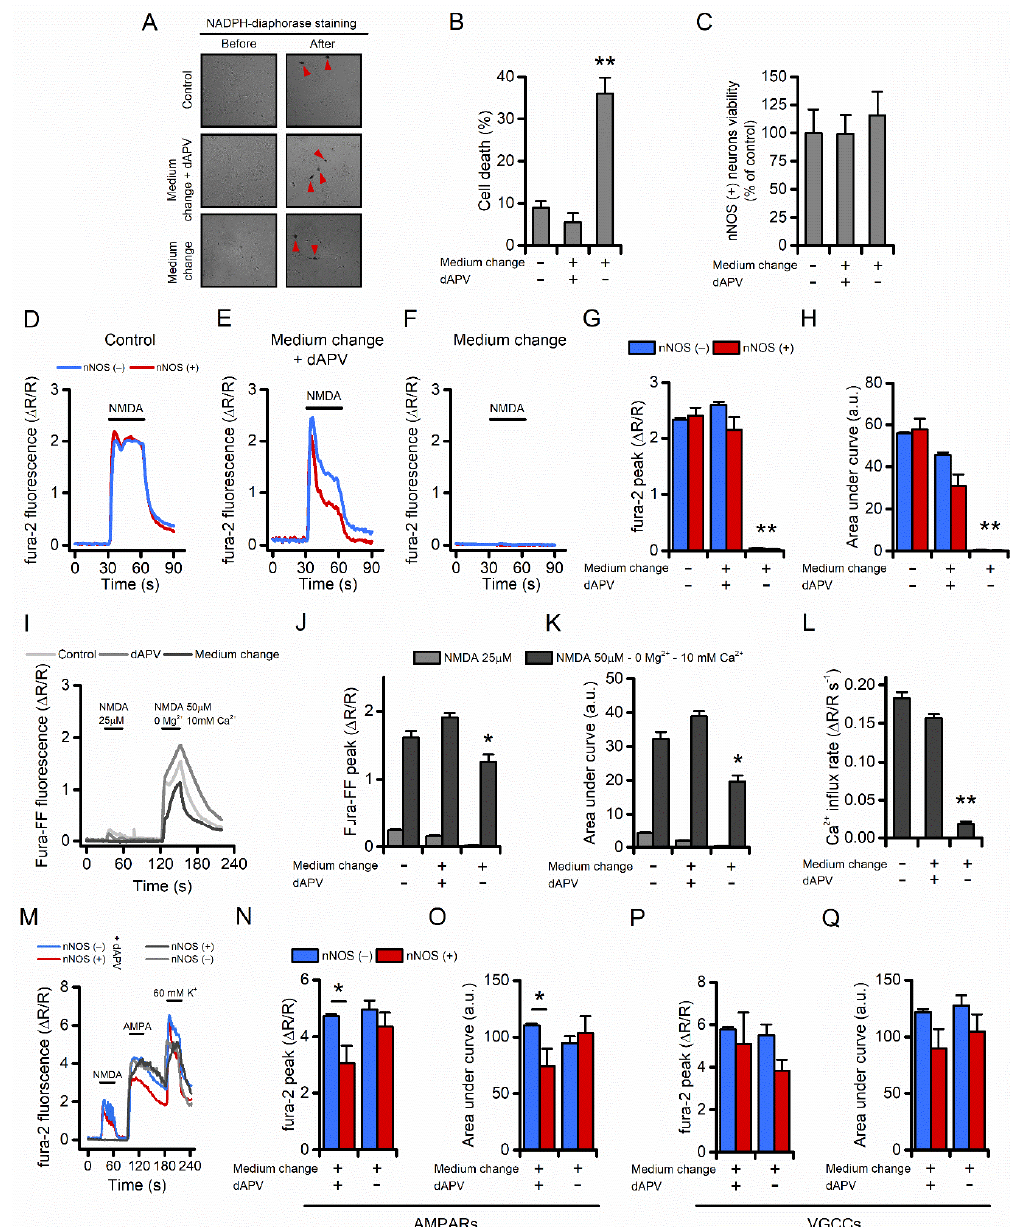
Figure 5. Neurons spared after an excitotoxic challenge fail to respond to NMDA stimulation. ( A ) The pictogram illustrates phase contrast images of untreated (top), medium change + dAPV-treated (middle), and medium change-treated (bottom) neuronal striatal cultures before (left) and after (right) the NADPH-diaphorase staining. Red arrowheads indicate nNOS (+) neurons. ( B ) Bar graph depicts the vulnerability of striatal cultures exposed to the treatments described in ( A ). Neuronal viability was assessed, with LDH efflux assay, 16 h after the challenge (neuronal death in naïve neurons: 8.9 ± 1.5% vs. 5.4 ± 2.2% in dAPV group vs. 36.0 ± 3.8% in medium exchange group, F (2, 45) = 37.56, p < 0.0001). ( C ) Bar graph depicts the relative abundance of nNOS (+) neurons expressed as % of control sister cultures [control cultures: 100.0 ± 21.0% vs. 99.3 ± 16.0% in dAPV group vs. 115.9 ± 21.0% in medium exchange group, F (2, 119) = 0.23, p = 0.78). ( D – F ) Representative time courses of fura-2 loaded nNOS ( − ) and nNOS (+) striatal neurons exposed to NMDA (25 µ M + 2–5 µ M glycine) 16–20 h after being exposed to the indicated treatment. ( G ) Bar graphs show quantification of fura-2 peak